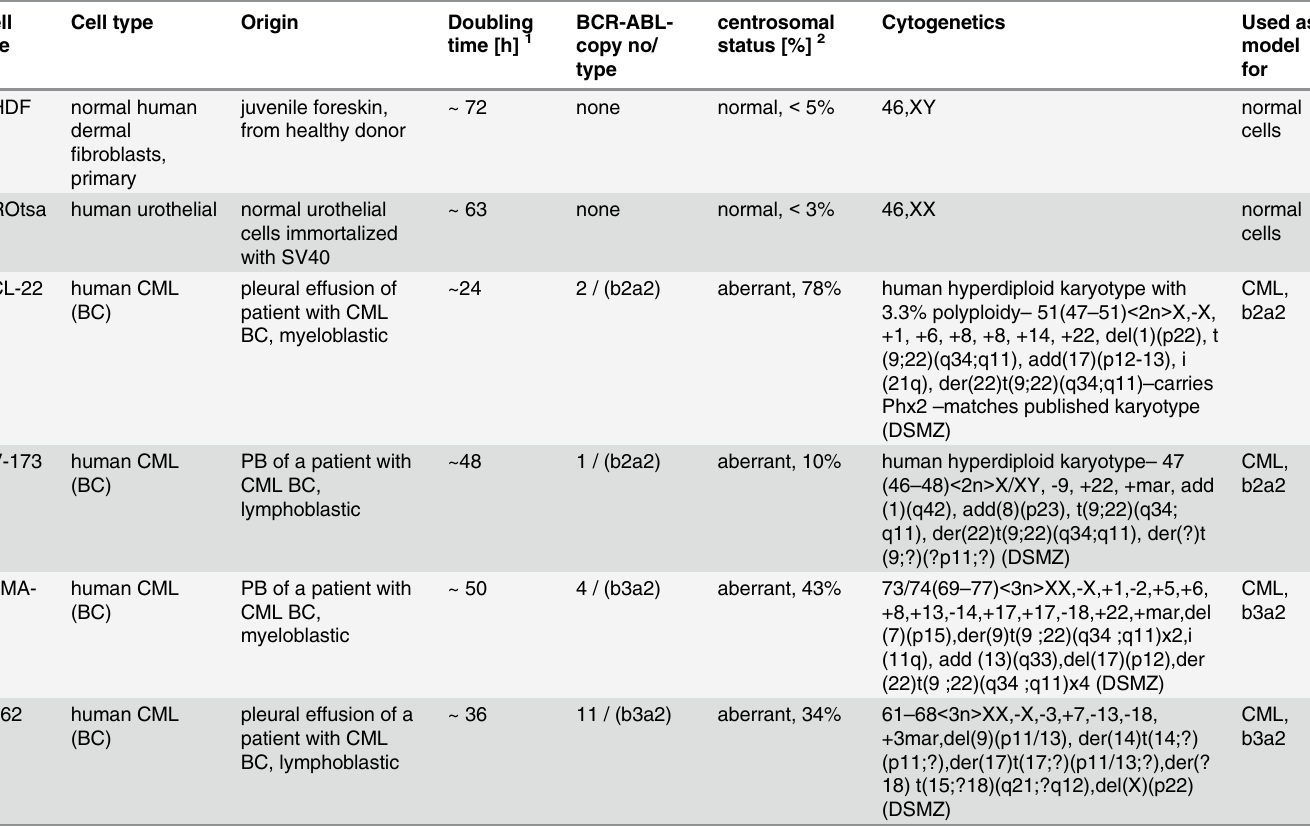
Table 3. Origin and characteristics of human cell line models under